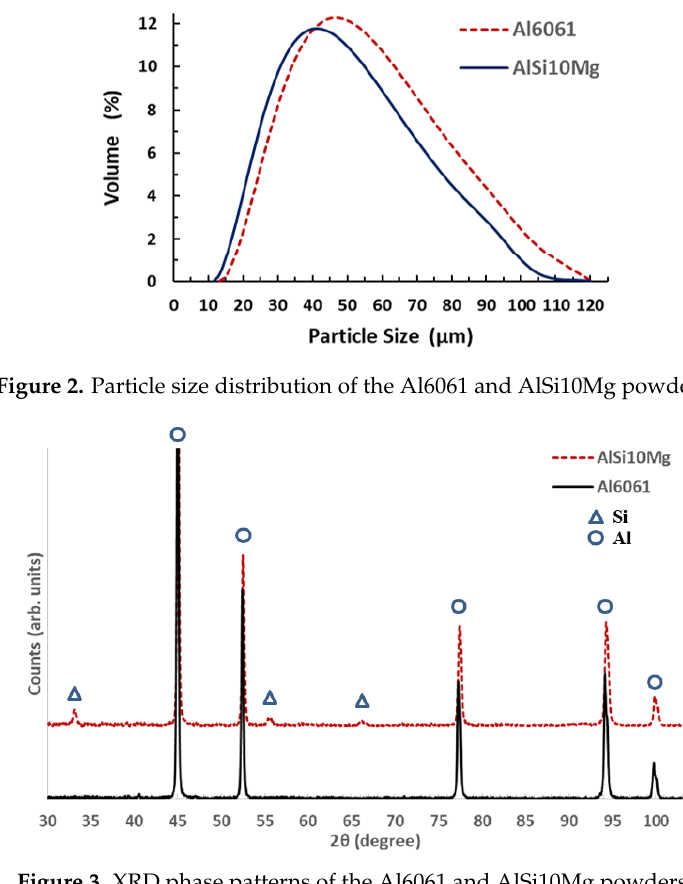
Figure 3. XRD phase patterns of the Al6061 and AlSi10Mg